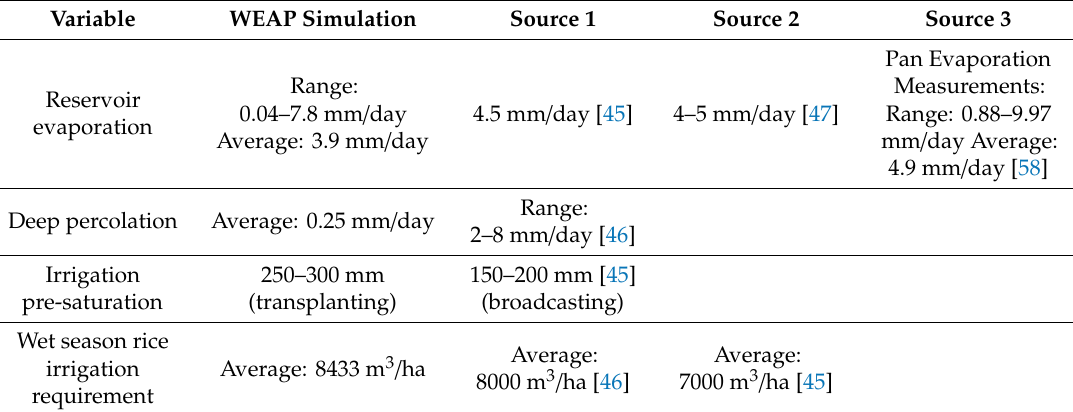
Table A5. Comparisons between WEAP outputs and values reported in other